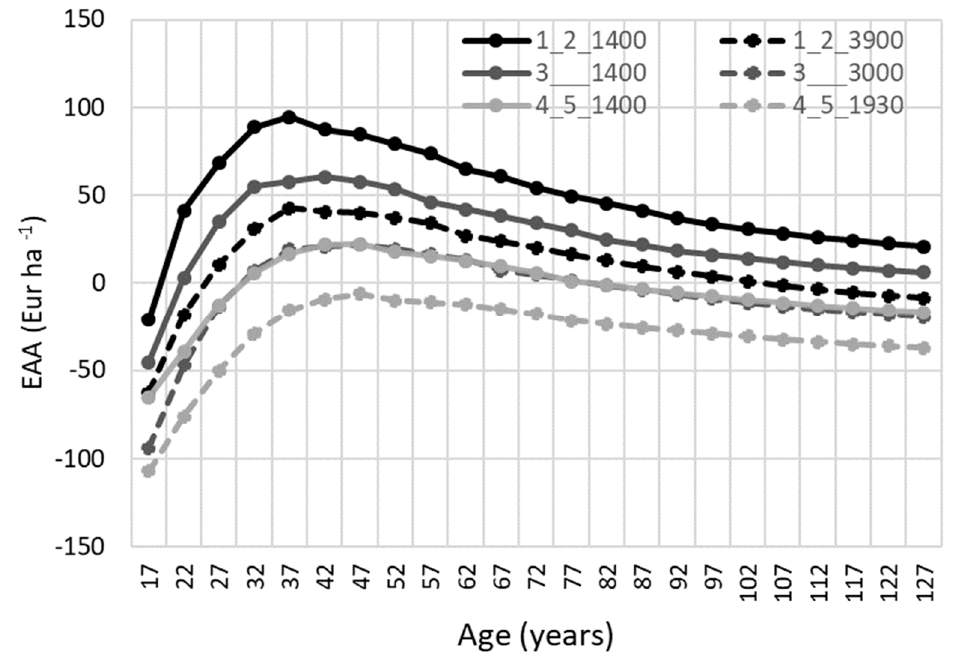
Figure 5. Equivalent annual annuity (EAA) dynamics with an interest rate of 4% for di ff erent initial densities (1400 trees ha − 1 and actual density at the age of 17 years) and damage grades applying thinning regime 1 (reducing relative stand density from 0.95 to 0.70). Simulated scenarios: 1_2_1400: damage grades 1 to 2 with a density of 1400 trees ha − 1 ; 1_2_3900: damage grades 1 to 2 with a density of 3900 trees ha − 1 ; 3_1400: damage grade 3 with a density of 1400 trees ha − 1 , 3_3000: damage grade 3 with a density of 3000 trees ha − 1 , 4_5_1400: damage grades 4 to 5 with a density of 1400 trees ha − 1 , and 4_5_1930: damage grades 4 to 5 with a density of 1930 trees ha − 1 .